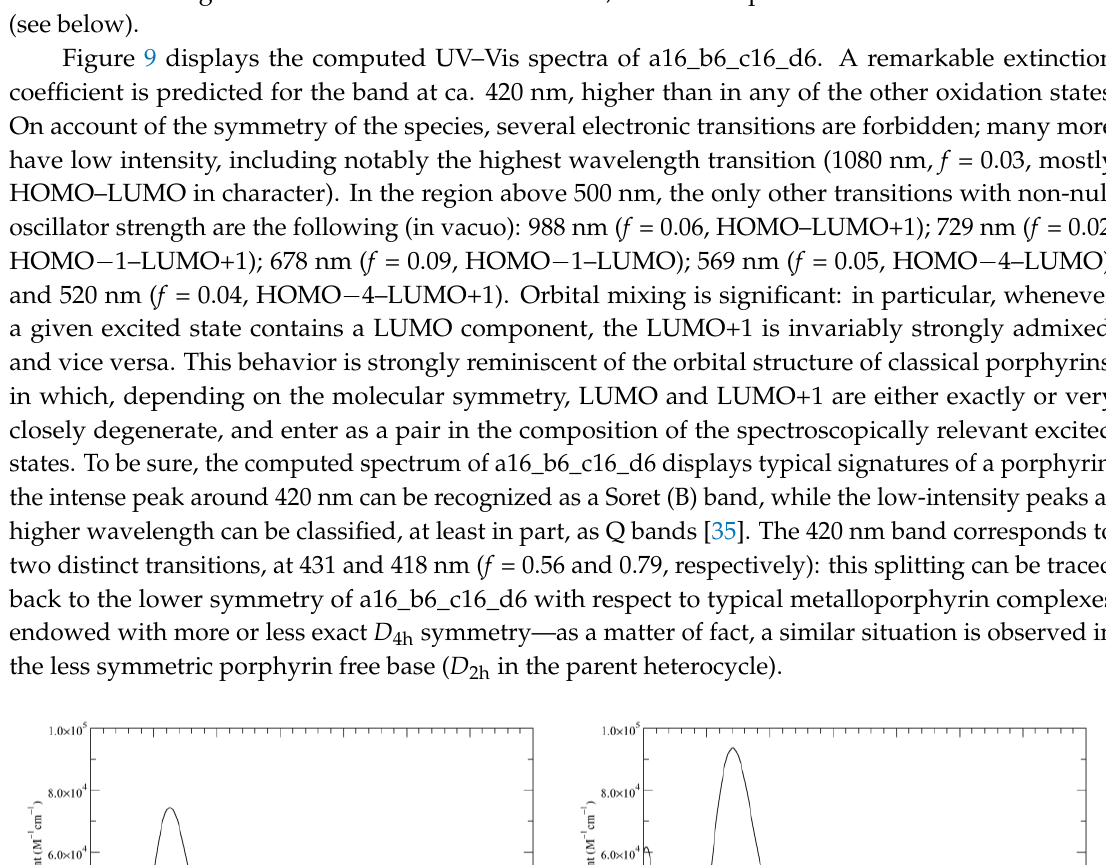
Table 14. Excitations underlying the UV–Vis spectrum of a16_b6_c16_d6, computed at the C 2h geometry in vacuo. Symmetry Main CI Contributions (Coefficients) a